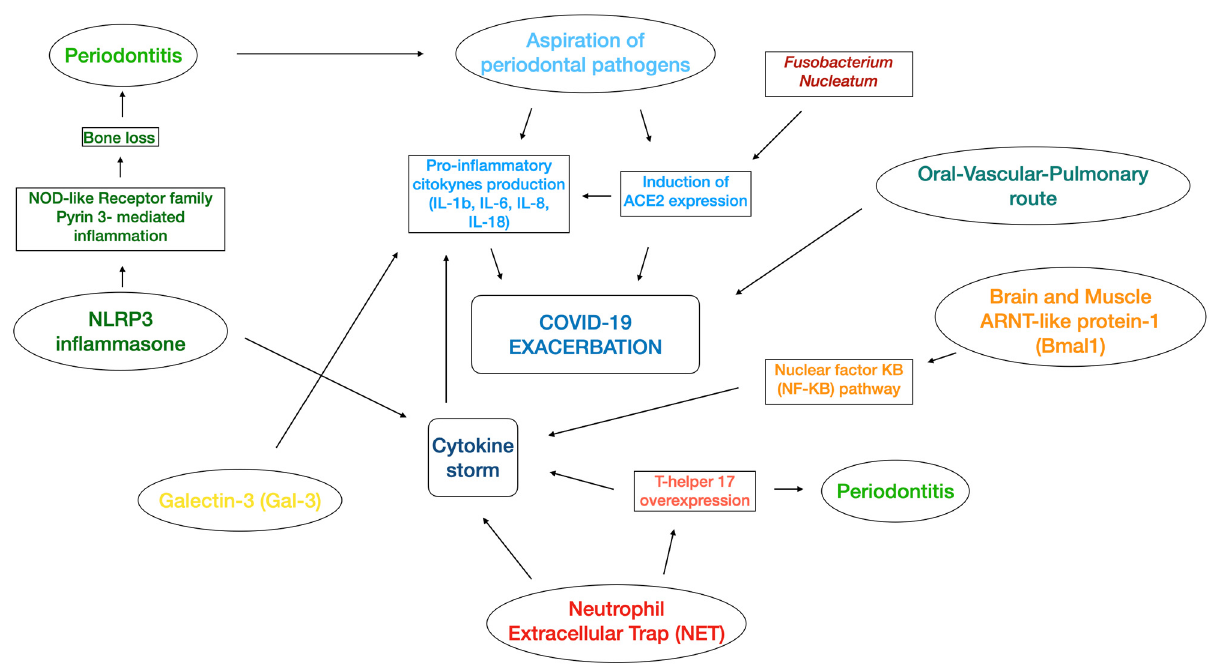
Figure 1. Illustration of the several mechanisms related to the association between periodontitis and COVID-19. NLRP3 inflammasone: nucleotide-binding domain, leucine-rich repeat pyrin domain containing 3 inflammasone; ARNT-like protein 1: aryl hydrocarbon receptor nuclear translocator-like protein 1; IL: Interleukin; NOD-like receptor: nucleotide-binding and oligomineralization domain-like receptor.